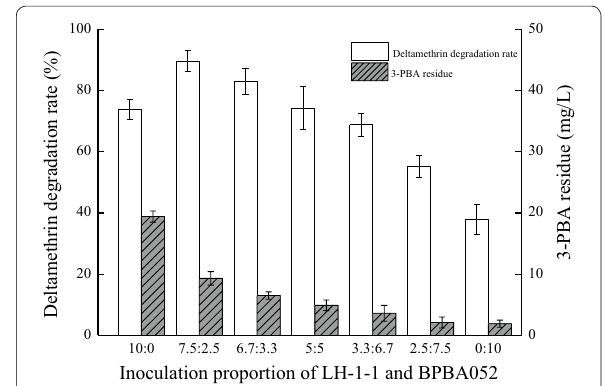
Fig. 2 Deltamethrin degradation and 3-PBA content by using different inoculation proportions of strains LH-1-1 and BPBA052